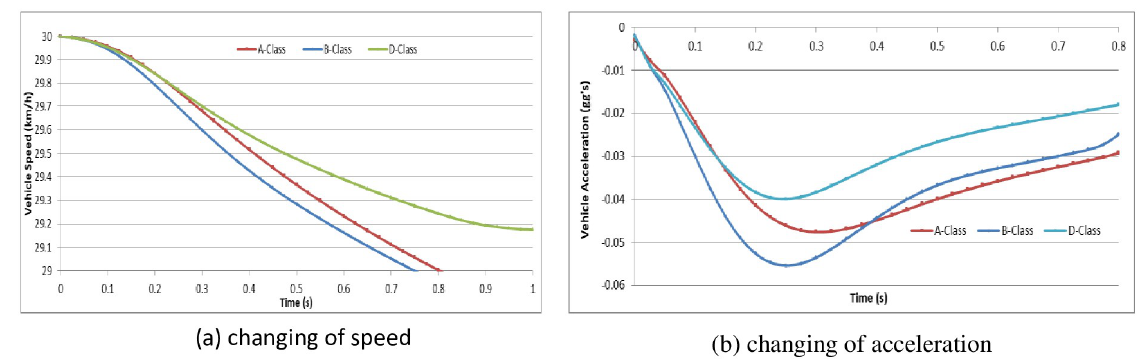
Fig 10. The changes in vehicle speed and acceleration during the reactions at initial speed = 30 km/h with different vehicle models (Group 1).